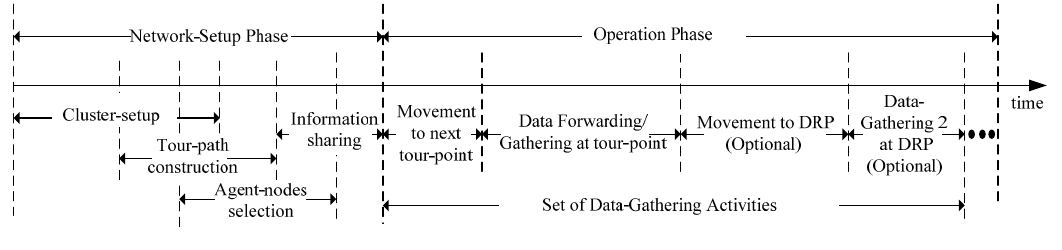
Figure 4. Timeline of the proposed scheme.